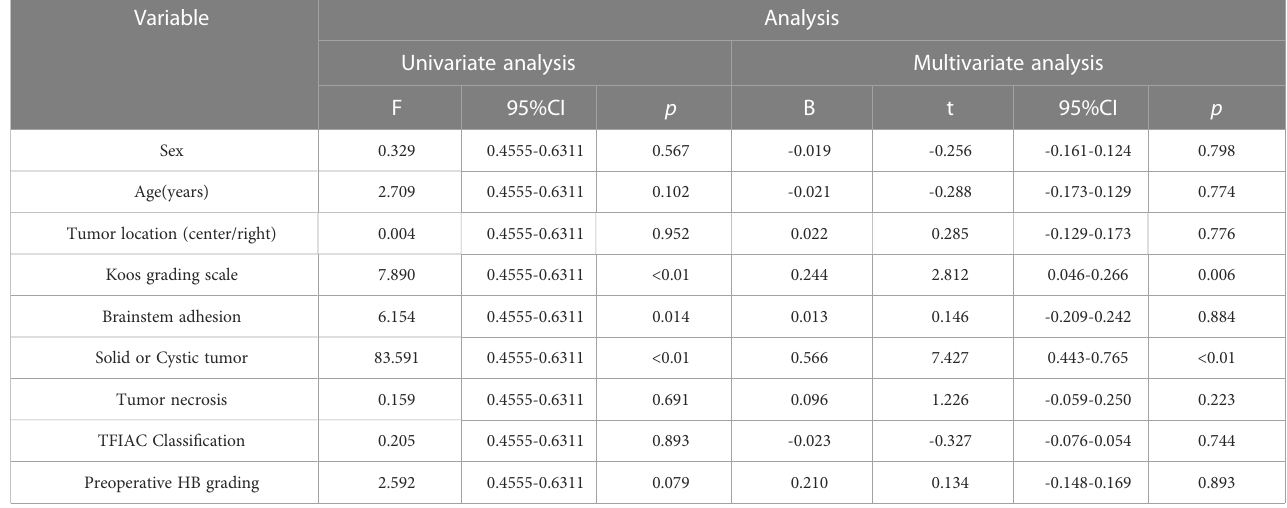
TABLE 4 Univariate analysis and multivariate analysis of risk factors for NI injury in VS patients.